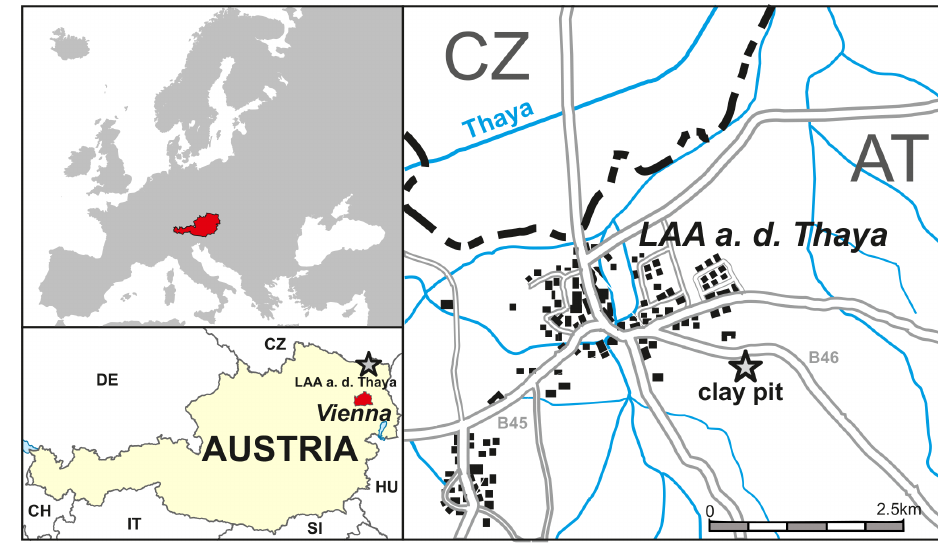
Figure 1. Map showing the position of the studied outcrop near Laa an der Thaya in Lower Austria (after Auer et al., 2014).